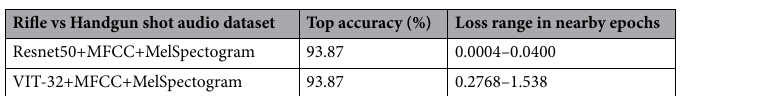
Table 3. Resnet vs ViT top training accuracy and loss range in nearby epochs.